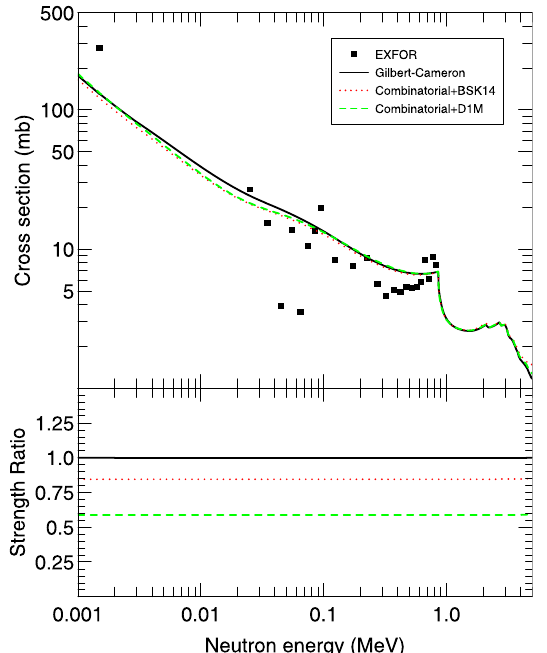
Fig. 8. Top panel: 56 Fe( n , g ) 57 Fe cross-section as function of the neutron incident energy. The black squares correspond to EXFOR data [29], the full black line is the prediction obtained using the default level density model implemented in the TALYS code [1,30], the red dotted line using the combinatorial level density model of reference [31] and the green dashed line the combinatorial level density model of reference [32]. Bottom panel : ratio between the strength functions obtained after the normal- ization deduced from equation (3) is applied and the strength function corresponding to the default level density option.